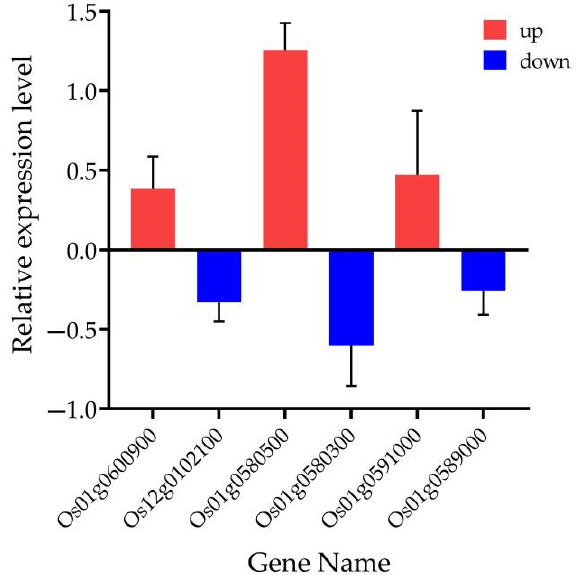
Figure 14. Real-time quantitative PCR validation of transcriptome data for six selected DEGs be- Ce679 and R4233. The data were obtained from six independent tween Ce679 and R4233. The data were obtained from six independent repeats.